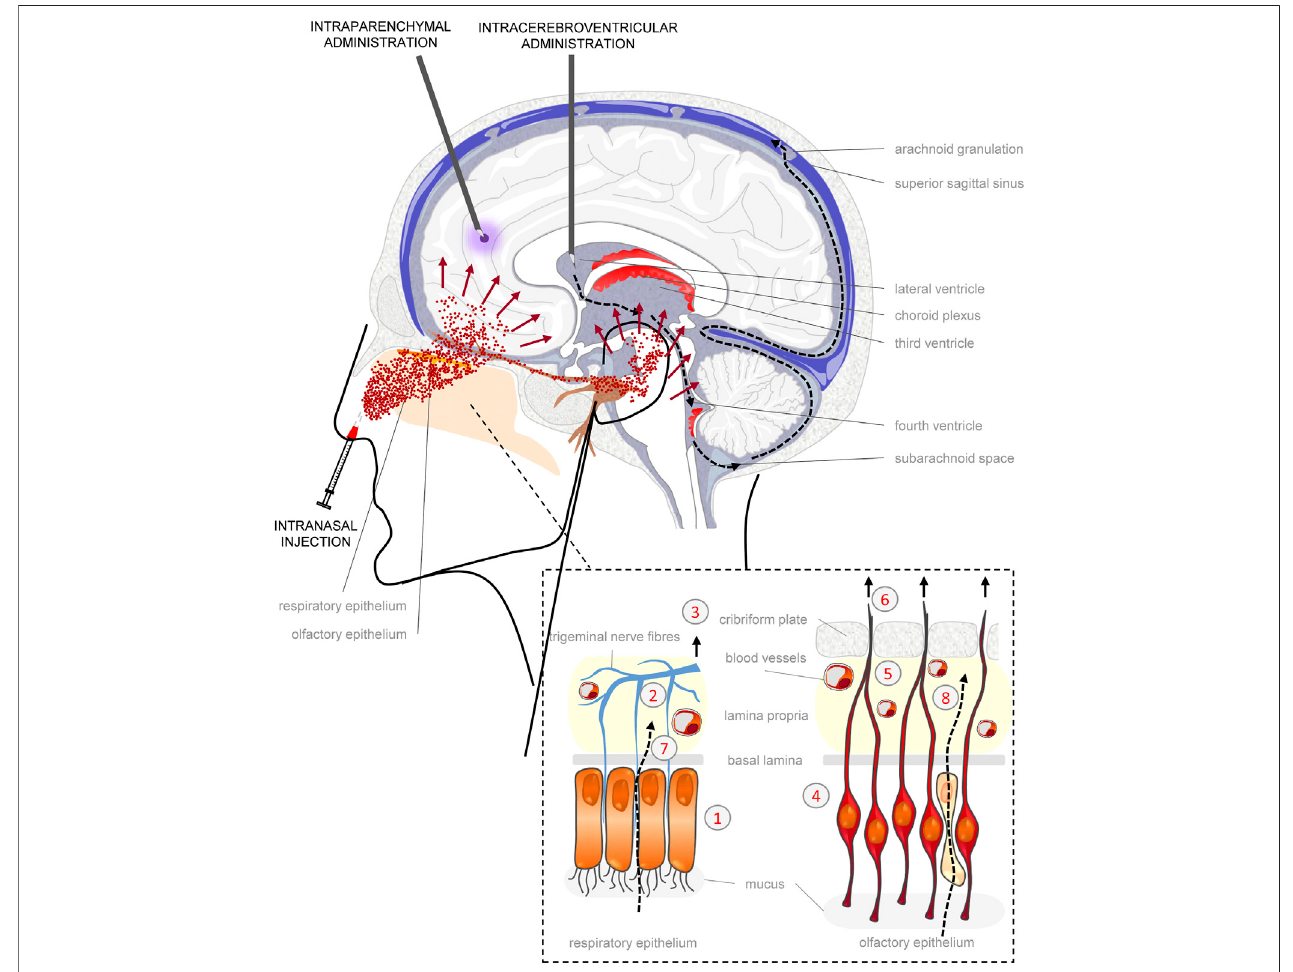
FIGURE2 | Mechanisms ofexogenousbiomoleculedistribution tothe braintissue.Intraparenchymal (IP) administration allows the local delivery of biomolecules in CNS tissue, limiting distribution to an area no more than about 2 mm from the site of introduction (violet spread). Intracerebroventricular (ICV) administration may deliver biomolecules to wide areas of CNS as a result of circulation within cerebrospinal fl uid (CSF) (black dotted arrows). From the lateral ventricle, through the fourth ventricle biomolecules can reach the subarachnoid space where the CSF is fi ltered by arachnoid granulations in the bloodstream of the superior sagittal sinus. However, many limitations affect ICV administration: penetration into the underlying parenchymal tissue (about 2 mm), rapid clearance (NGF half-life < 1 h, in the 150 ml of CSF, which is replaced entirely within 8 h), sequestration because of binding to protein component of CSF. Intranasal (IN) injection is a non-invasive alternative to both IP and